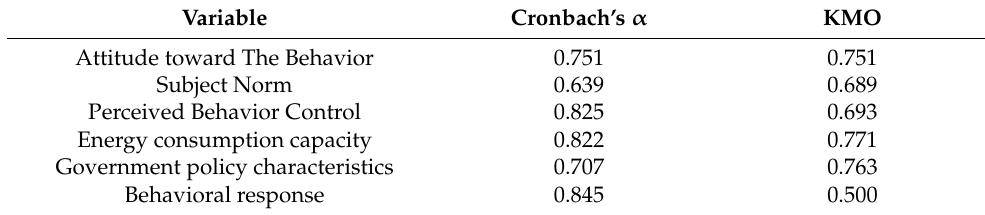
Table 4. Results of factor analysis.